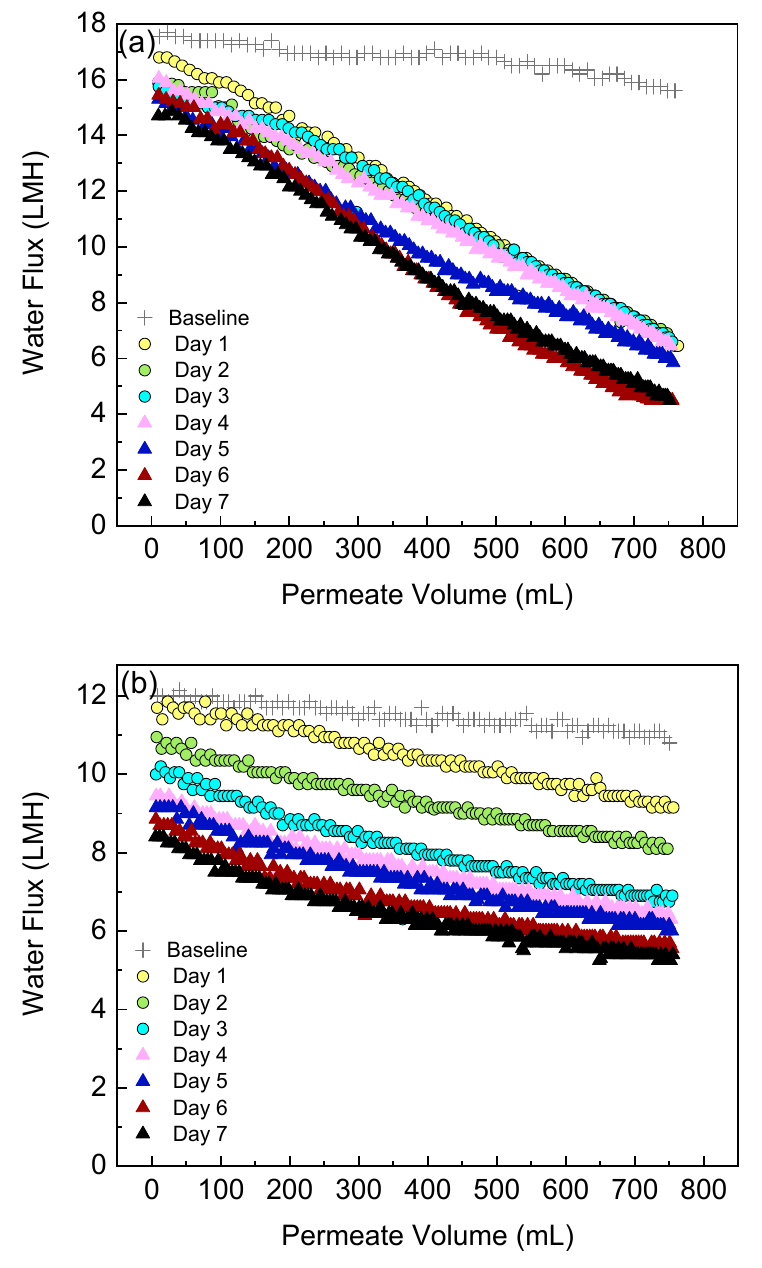
Figure 6. Change in permeate water flux during FO-PBR operation: ( a ) side-stream and ( b ) sub- merged FO configurations.